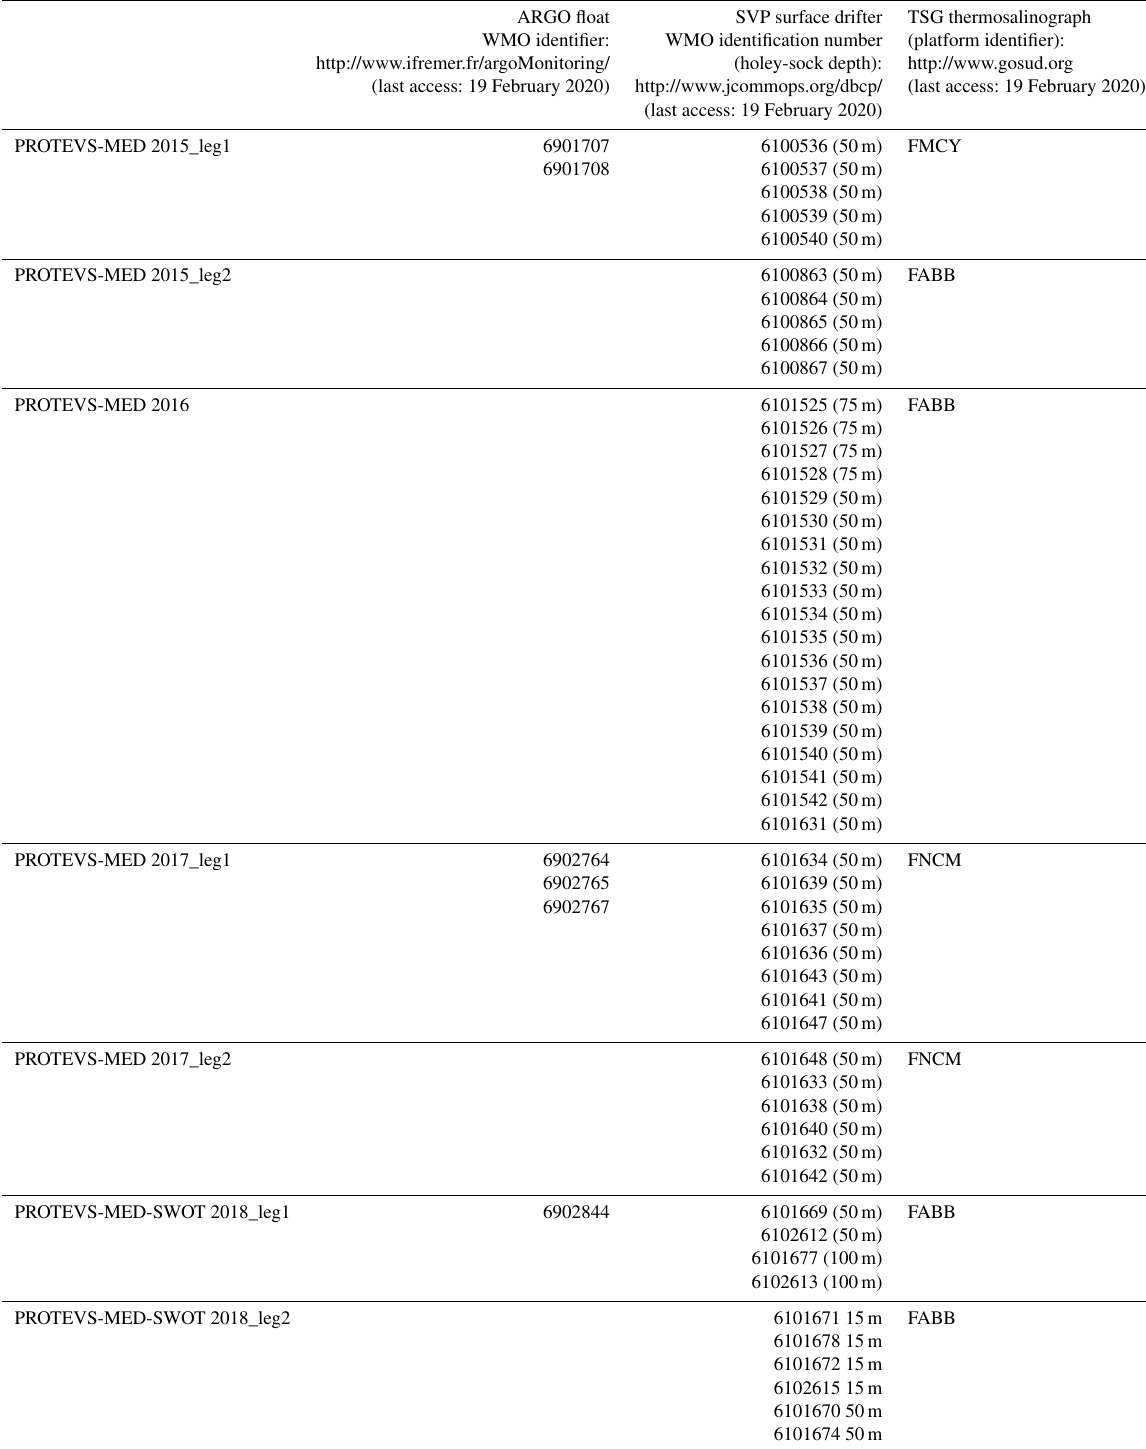
Table 2. WMO index of Argo float and surface drifters (SVP) dropped during PROTEVS-MED surveys. Surface temperature and salinity recorded by thermosalinograph (TSG) are tagged by ship identifier. All data are available from the CORIOLIS website at: http://www.coriolis. eu.org/Data-Products/Data-Delivery/Data-selection (last access: 19 February 2020) by entering the WMO numbers in the field “Platform codes”, adjusting the time period of interest (e.g., 1 January 2018 to 30 June 2019) and clicking on “refresh”. The web interface displays the trajectories of the buoys, profilers or TSG and can be used to find additional opportunity data. The data can then be downloaded in NetCDF